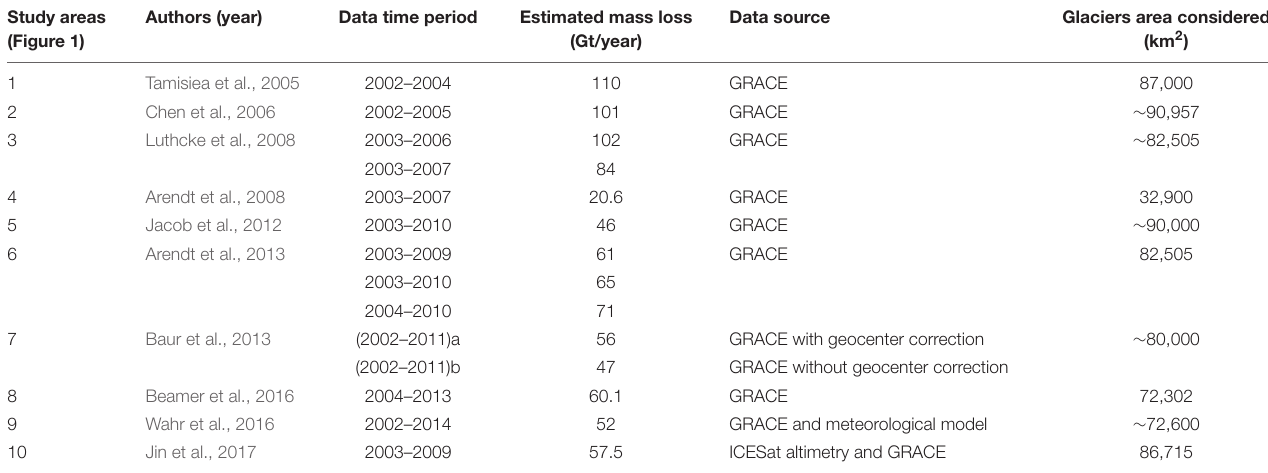
TABLE 1 | Estimates of glacier mass loss in the GOA according to different authors.